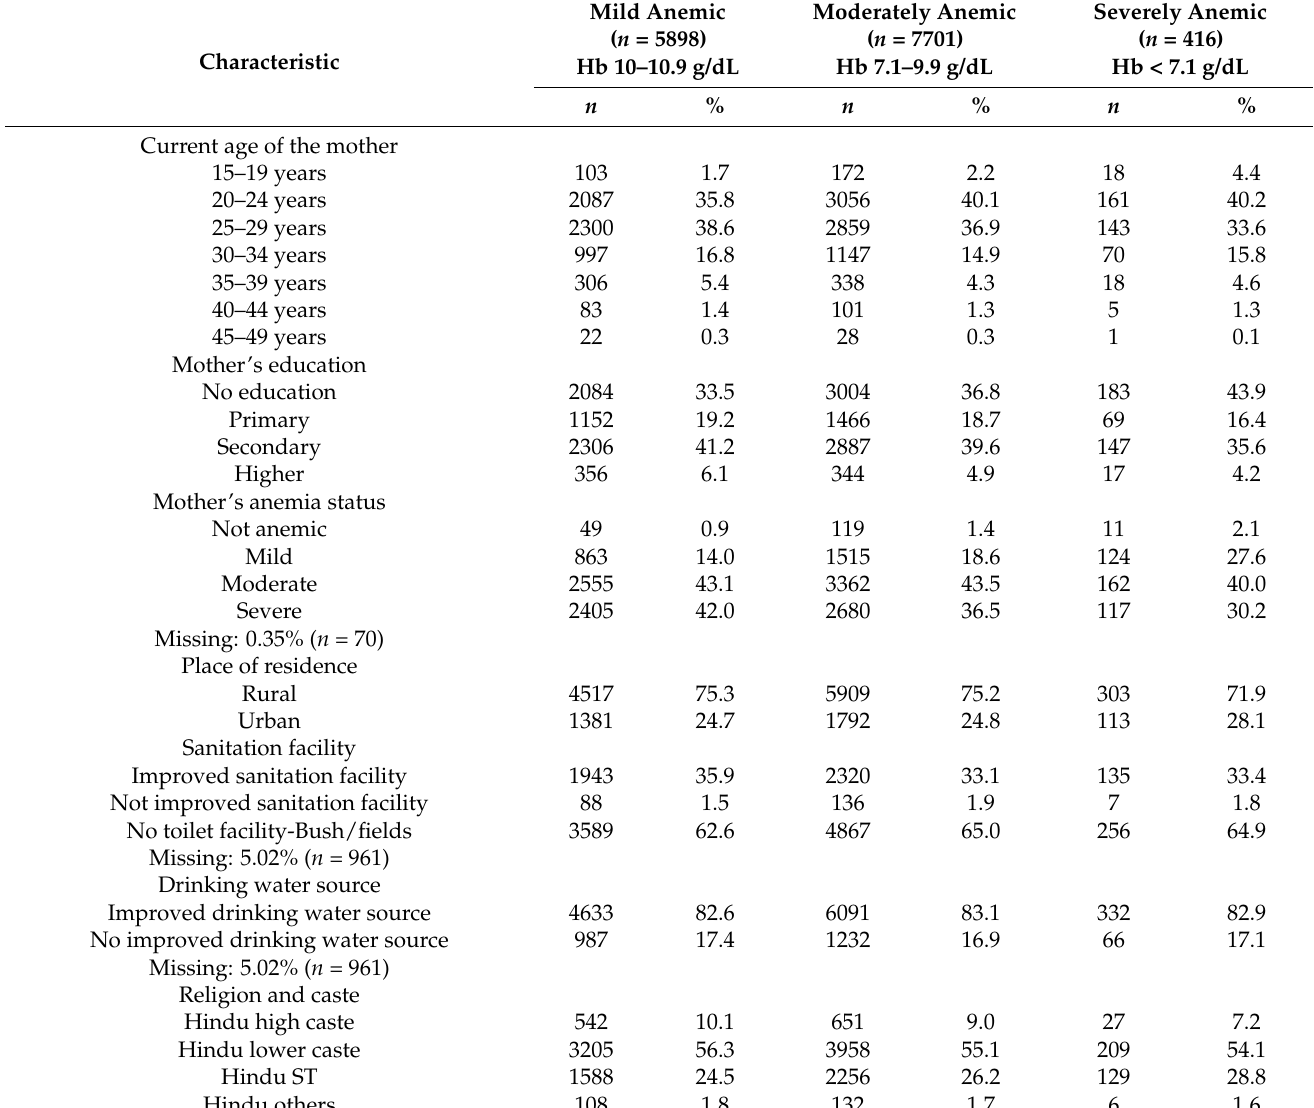
Table 2. Demographics and household characteristics of children under aged 6–59 months in Madhya Pradesh by anemia